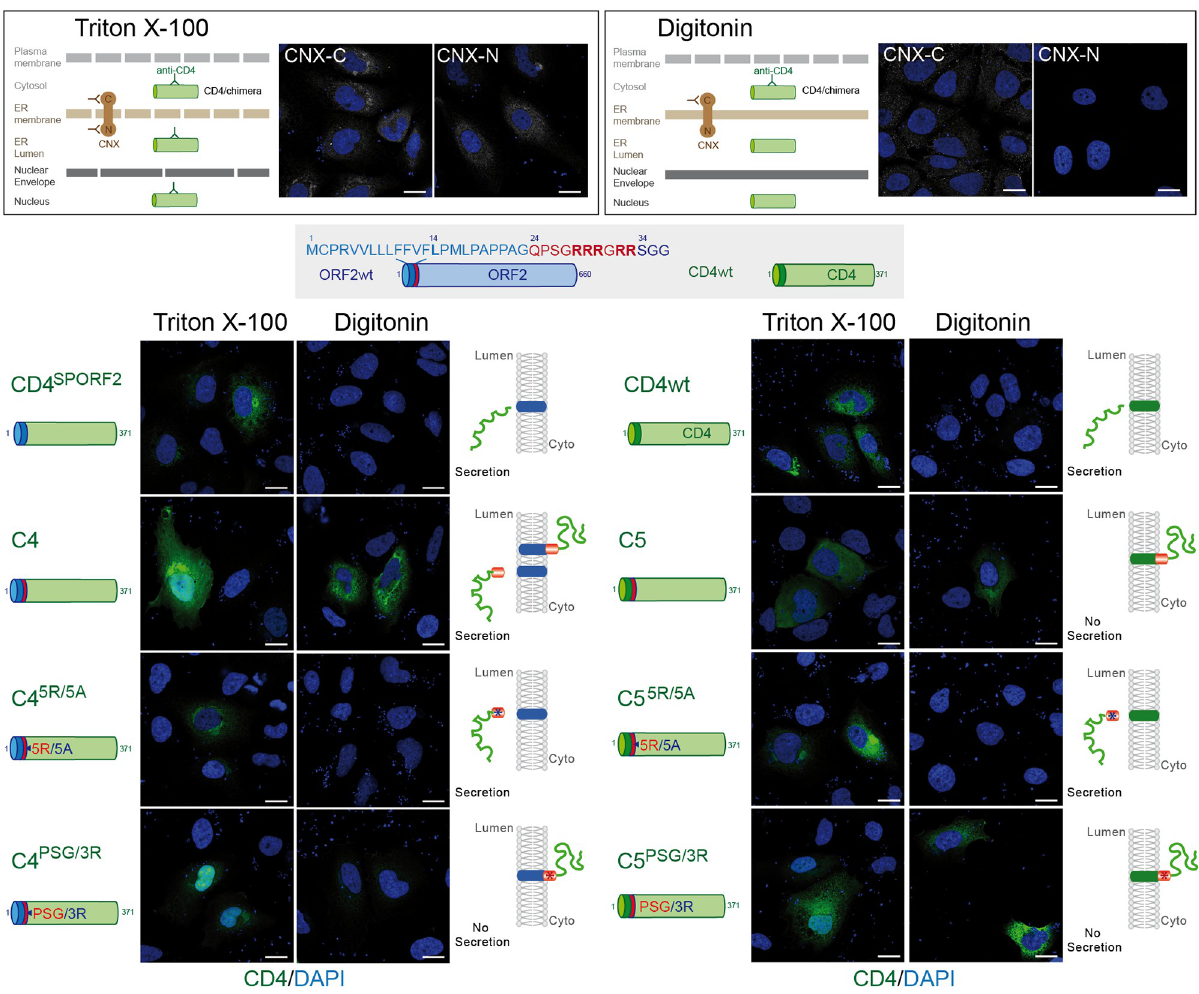
Fig 8. The ORF2 ARM is also able to control the topology of CD4 SP. A schematic representation of differential permeabilization process with Triton X-100 and Digitonin is shown. Representative images of the differential detection of two epitopes on the ER-membrane associated Calnexin (CNX) in the used permeabilization conditions are shown. H7-T7-IZ cells were transfected with pTM plasmids expressing CD4wt or chimeric C4 and C5 proteins. Twenty-four hours post-transfection, cells were fixed, permeabilized with either Triton X-100 or Digitonin, and processed for CD4 staining (in green). Nuclei are in blue. Representative confocal CD4/DAPI merge images are shown. Blue dots observed in some pictures are DAPI-stained transfected plasmids. A schematic representation of each construct is shown on the left and its predicted topology on the right. Blue and red asterisks correspond to 5R/5A and PSG/3R mutations, respectively. Scale bar, 20 μ